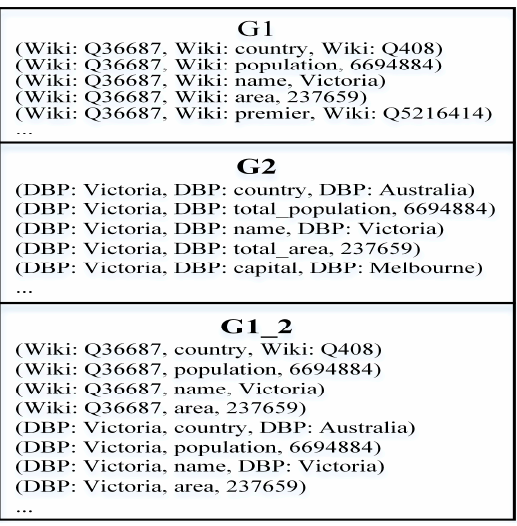
Figure 1. Ex ample of entity alignment. Figure 1. Example of entity